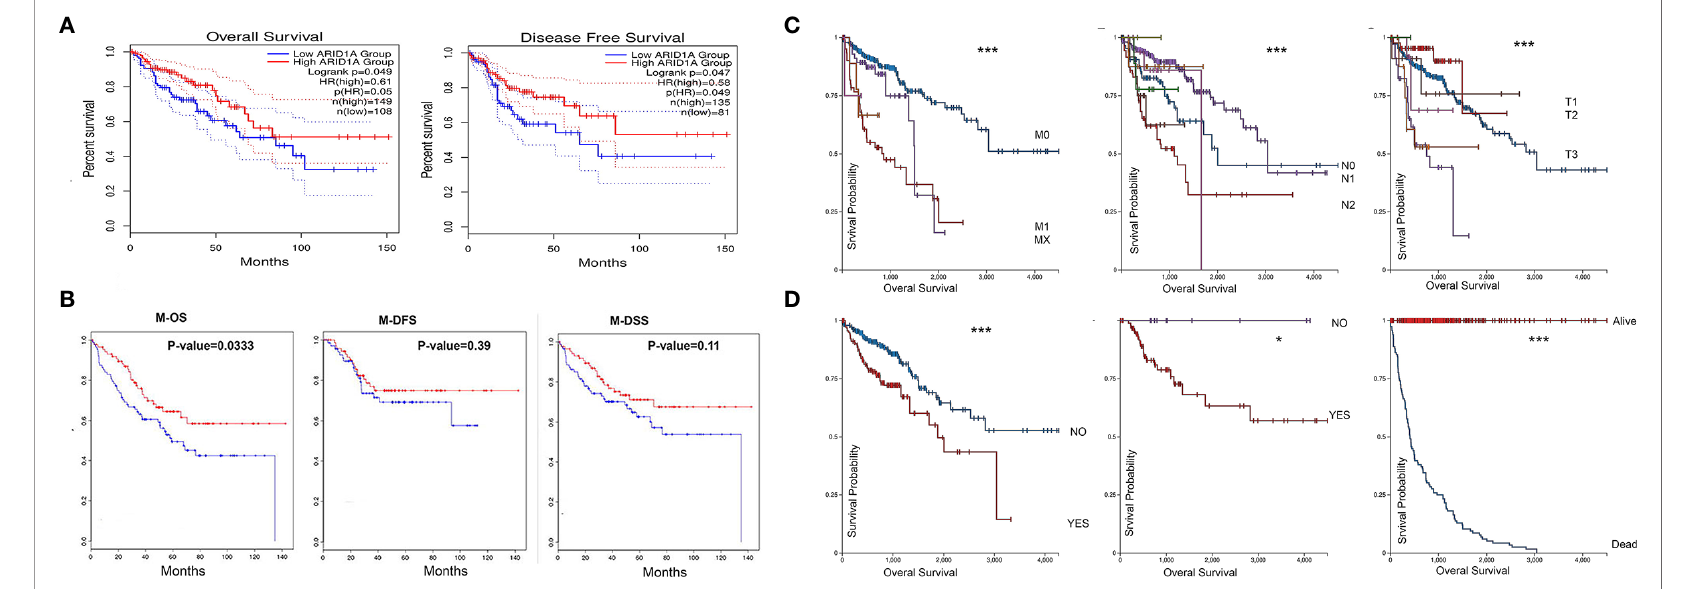
FIGURE 2 | COAD patients with low ARID1A mRNA levels had a poorer prognosis and predictive value in the pathological stages of COAD. (A) Prognostic value of ARID1A in primary colon adenocarcinoma using Kaplan-Meier plotter from GEPIA2, OS, Overall survival, DFS, Disease free survival; (B) Prognostic value of ARID1A in metastases using Kaplan-Meier plotter from CanEvolve: M-OS, Metastases overall survival, M- DSS, disease-speci fi c survival, and M-DFS, Metastases disease-free survival; (C) Pathologic M, pathologic N, and pathologic T, respectively; (D) Lymphatic invasion, microsatellite instability, and Vital status, respectively. * p < 0.05 and *** p <